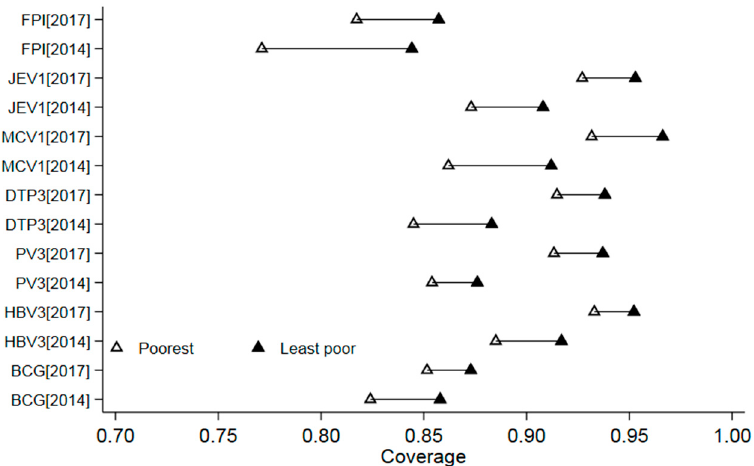
Figure 1. The distribution of coverage of the individual vaccine and FPI by socioeconomic status in the 2014 and 2017 coverage surveys (Notes: HBV3 means the 3rd dose of the hepatitis B vaccine (HBV); PV3 means the 3rd dose of the polio vaccine (PV); DTP3 means the 3rd dose of the diphtheria-tetanus-pertussis combined vaccine (DTP); MCV1 means the 1st dose of the measles-containing vaccine (MCV); JEV1 means the 1st dose of the Japanese encephalitis vaccine (JEV)). The CI values were 0.12028 (95% CI: 0.10852–0.13175) for the 2014 survey and 0.10129 (95% CI: